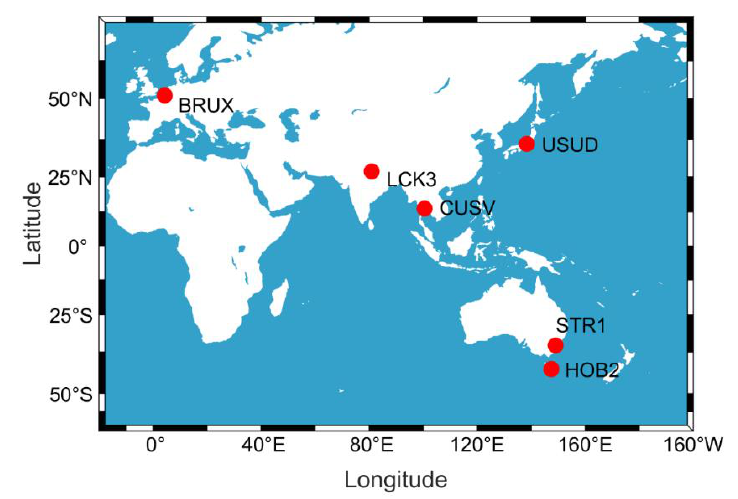
Figure 1. Principle of phase-smoothed pseudorange SF SPP time transfer based on BDGIM.